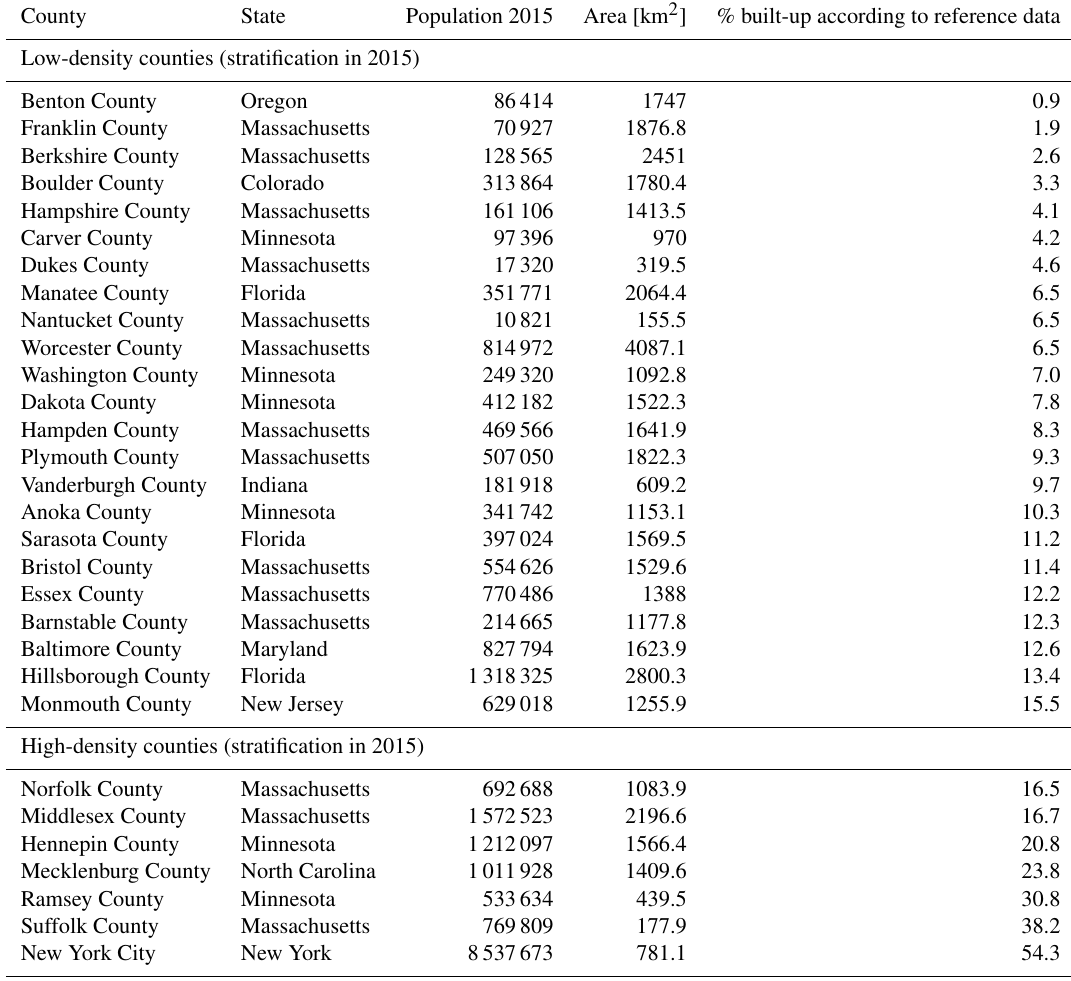
Table A1. List of 30 counties covered by the multi-temporal building footprint database